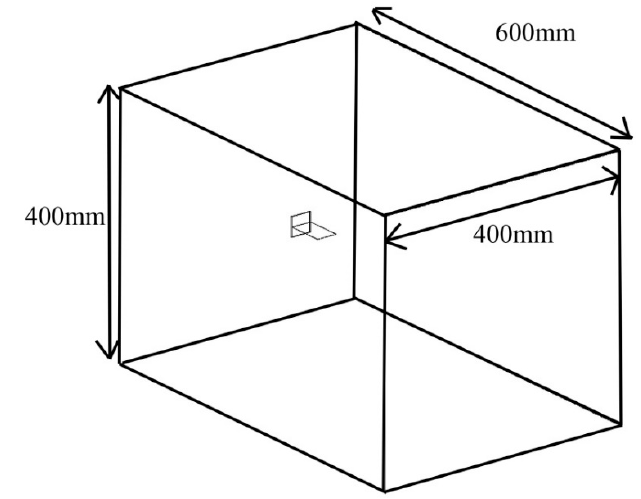
Figure 4. Fluid domain dimension and structural model dimension.